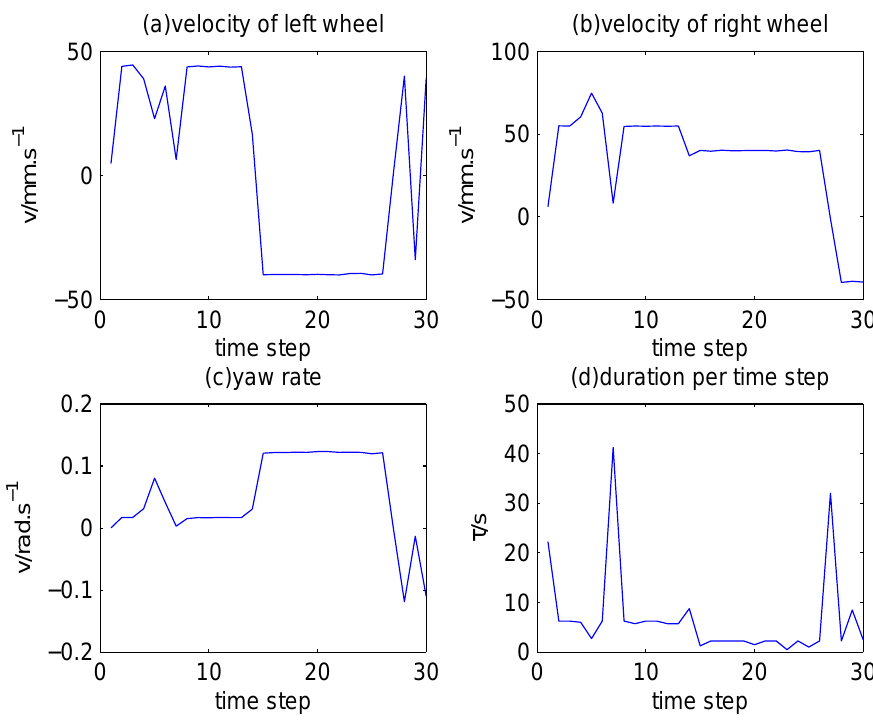
Figure 2. Velocity obtained from the readings of internal